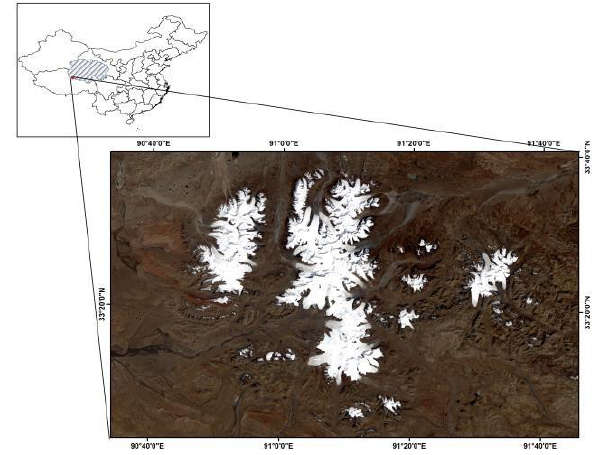
Figure 1. Geladandong location